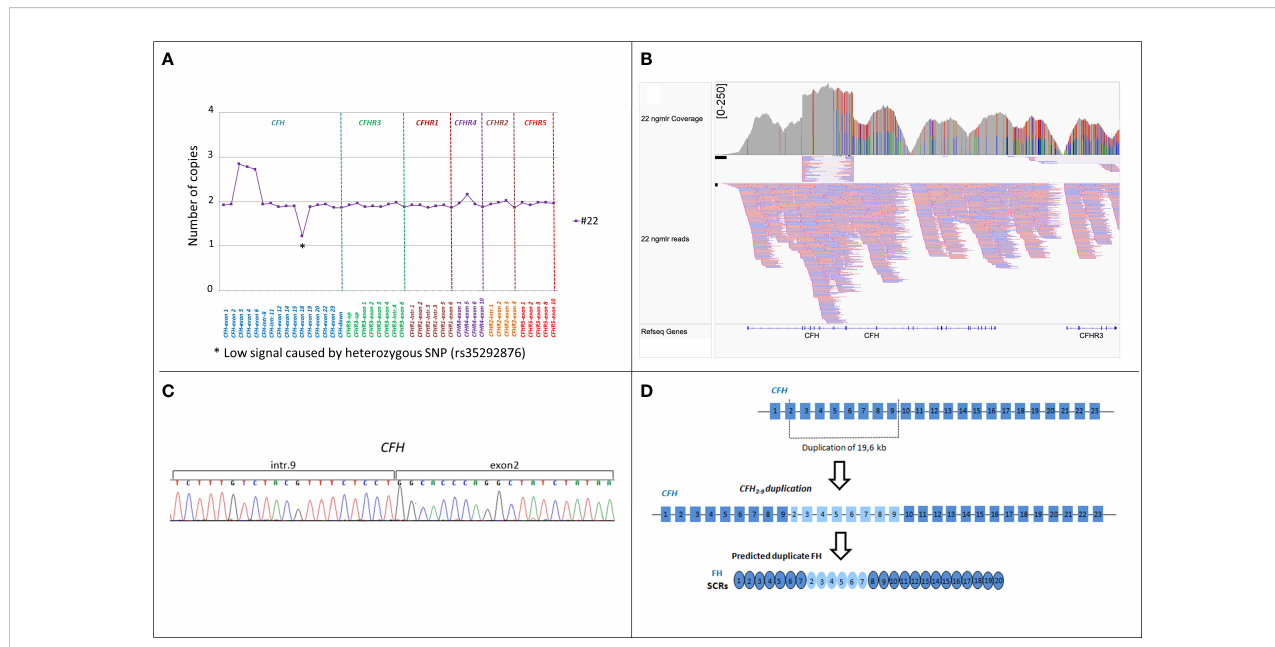
FIGURE 7 Identi fi cation of CFH 2-9 duplication in patient #22. (A) MLPA pattern in patient #22 shows a high signal on the exon 3, exon 4 and exon 6- CFH probes consistent with a heterozygous duplication. (B) Screenshot from IGV (Integrative Genomics Viewer) showing reads from SMRT sequencing. SMRT sequencing identi fi ed CFH 2-9 duplication. (C) Electropherogram of the genomic breakpoint. The fi rst part of the sequence corresponds to intron 9 of the CFH and the second part is the sequence of CFH exon 2. (D) Representation of 19,6 kb internal duplication of the CFH and the predicted resulting FH protein consisting of 26